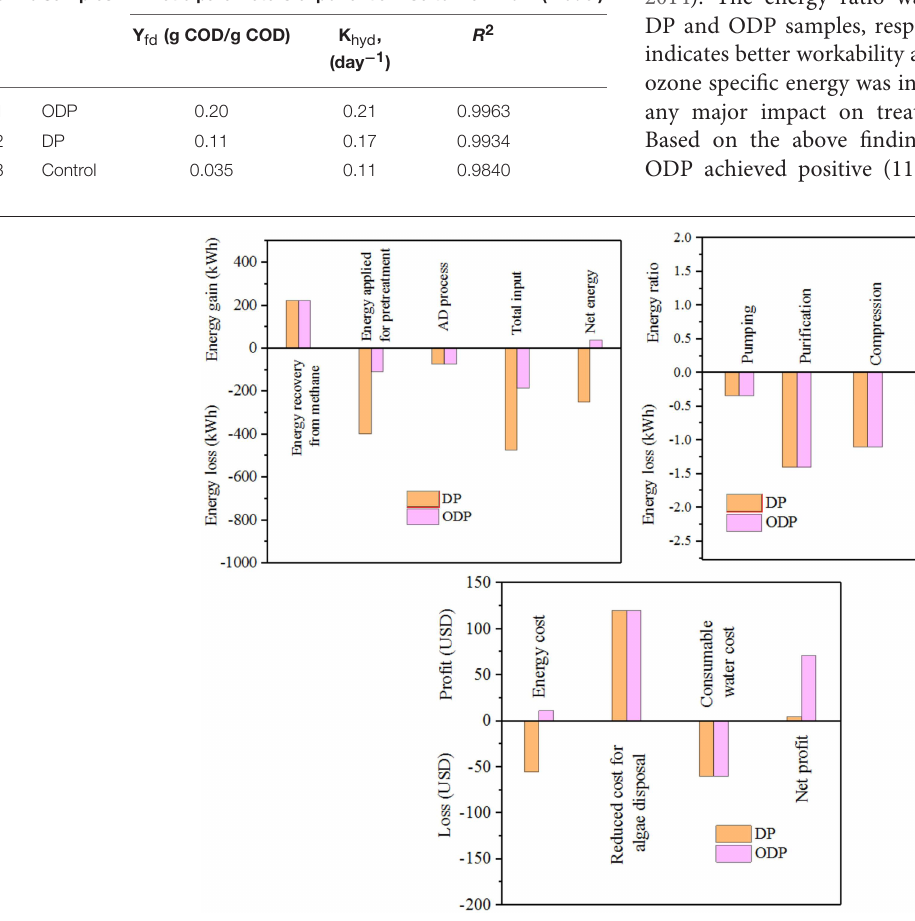
TABLE 2 | Modeling using non-linear regression for various MAB samples.